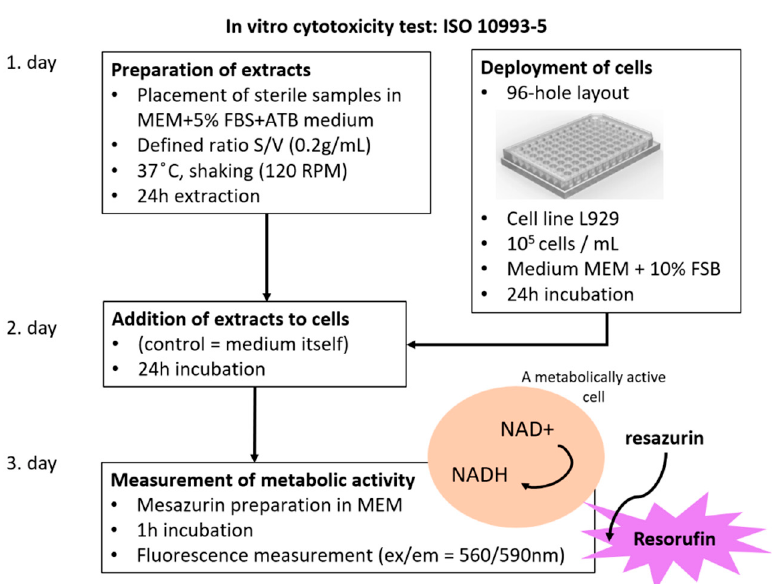
Figure 2. Details of the cytotoxicity test procedure.